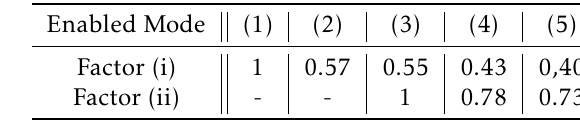
Table 2. Normalized middleware throughput performance of the scenario presented in Section 6.2. These results are computed from the throughput averages of the different modes. The mode of this table are similar to the used for Figure 9. Factor (i) presents the normalized performance with (1) as reference, while factor (ii) takes (3) as